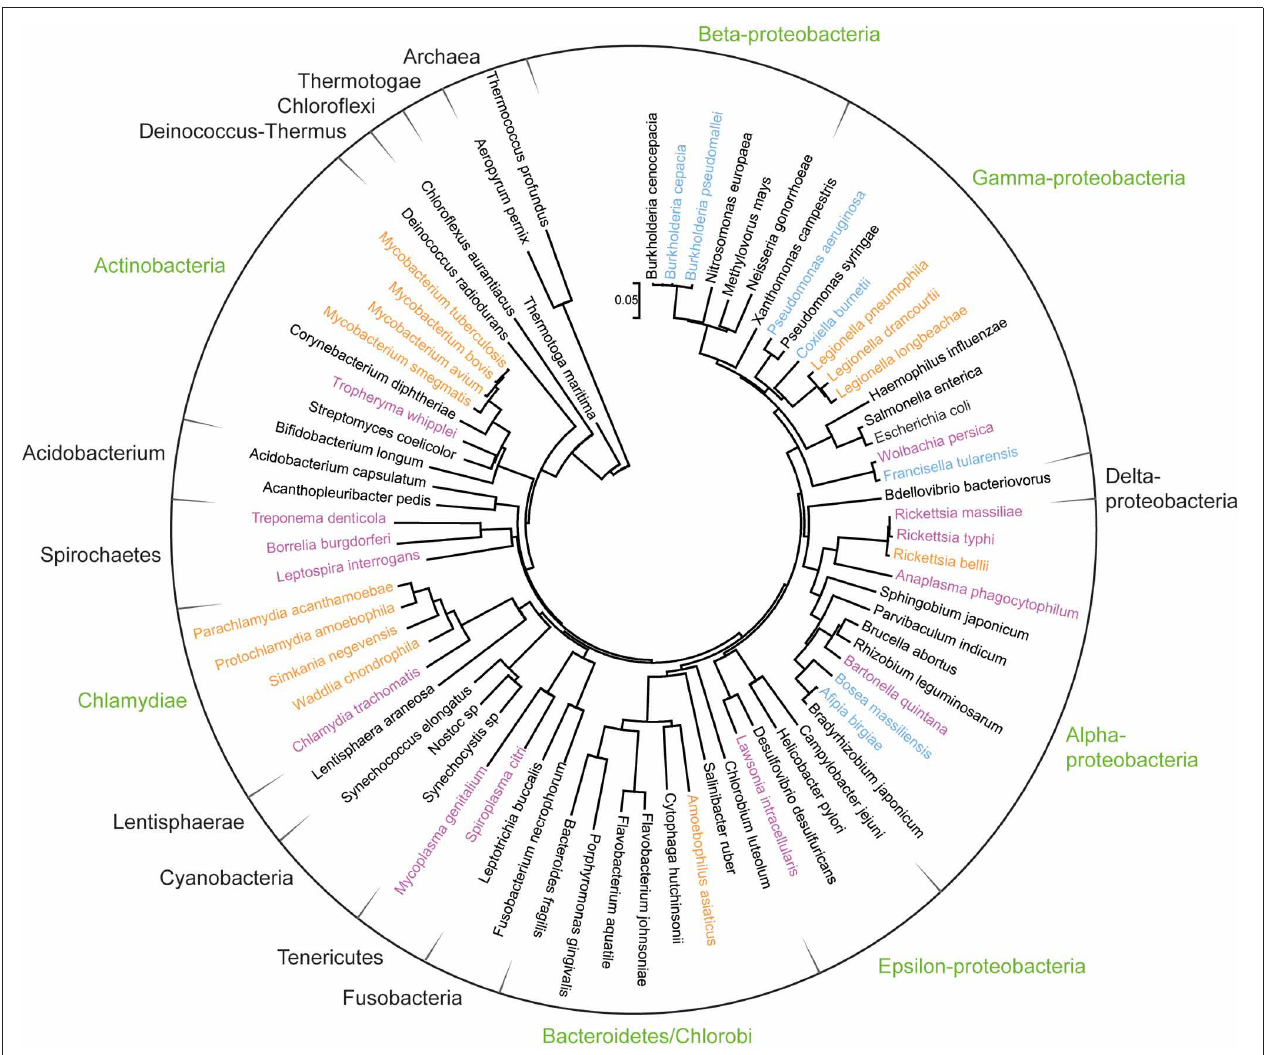
FIGURE 2 | Phylogenetic positioning of amoeba-resisting bacteria. The ribosomal RNA small subunit (16S) of Bacteria and two Archaea was aligned with Muscle and a neighbor-joining tree was subsequently built with Mega 5 (complete deletion, gamma distributed). The tree was rooted between Archaea and Bacteria. Bacterial phyla that comprise